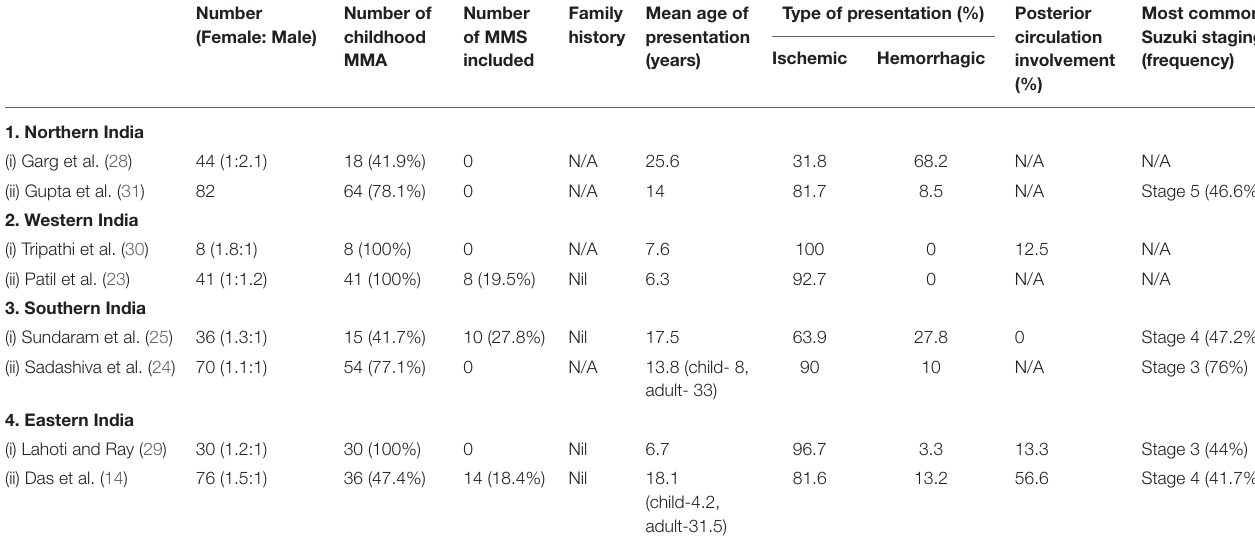
TABLE 9 | Representative epidemiological data on Indian MMA from previous